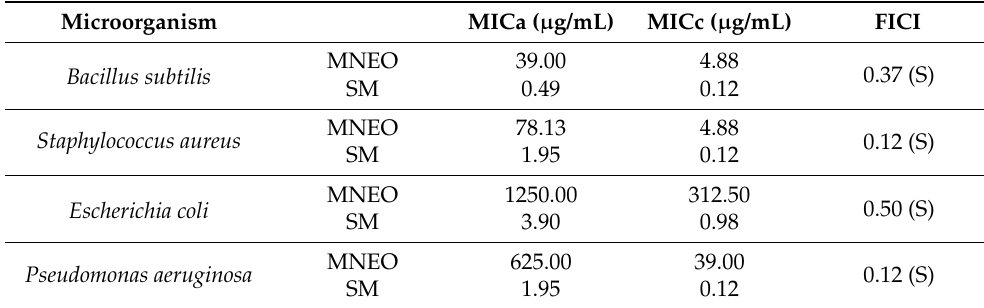
Table 4. Fractional inhibitory concentration index (FICI) values of the essential oil of M. nepalensis (MNEO) and streptomycin combinations.